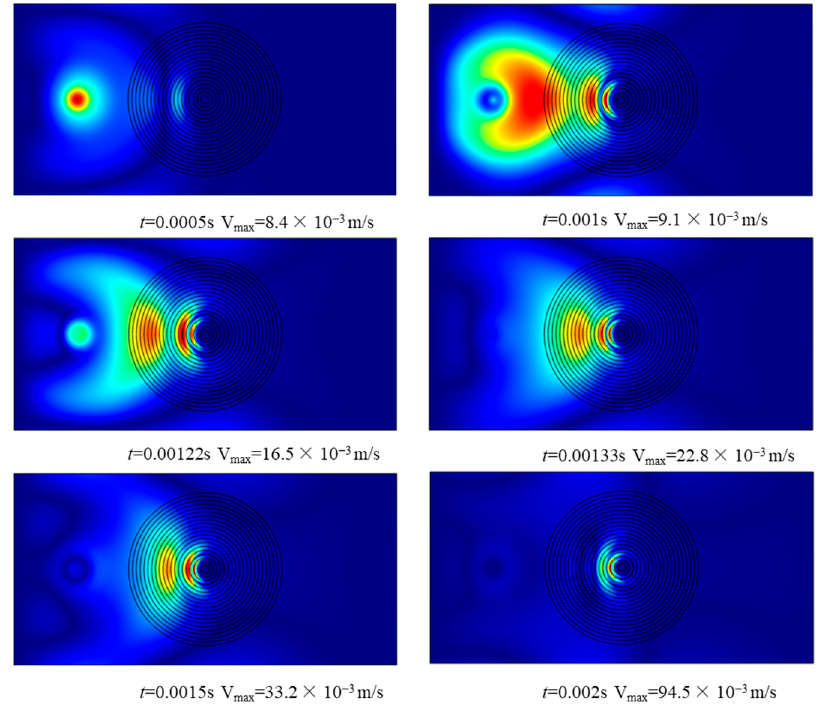
Figure 9. Transient analysis of 2D FGP structure.